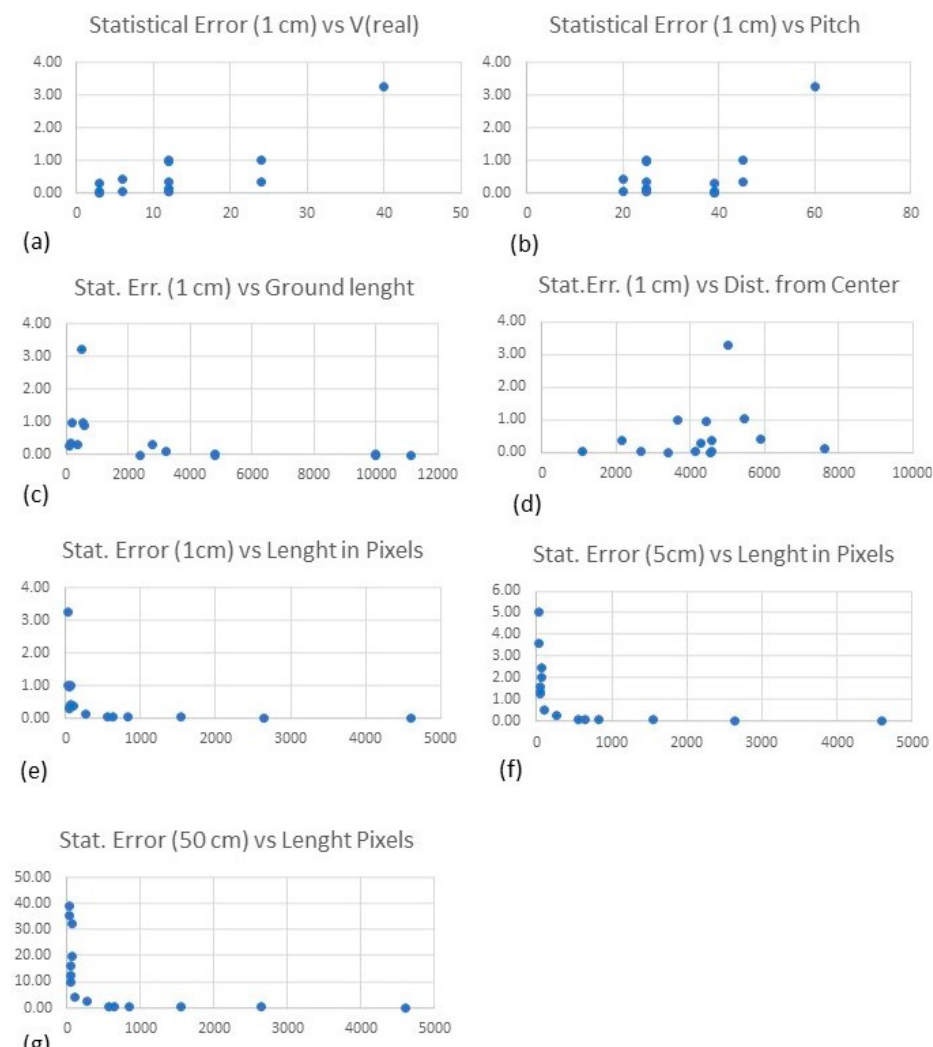
Figure 6. Parameters indicated in Table 1 plotted against the statistical error without considering the uncertainty of the Pitch angle (Statistical Error of 1cm versus real V ( a ), Statistical Error of 1cm versus Pitch ( b ), Statistical Error of 1cm versus Ground length ( c ), Statistical Error of 1cm versus Distance from Center ( d ), Statistical Error of 1cm versus Length in Pixels ( e ), Statistical Error of 5cm versus length in Pixels ( f ), Statistical Error of 50cm versus Length in Pixels ( g ). Ground length uncertainty equal to 1 cm is considered. Pixel length is also plotted against the statistical error when Ground length uncertainty is equal to 5 cm and 50 cm.